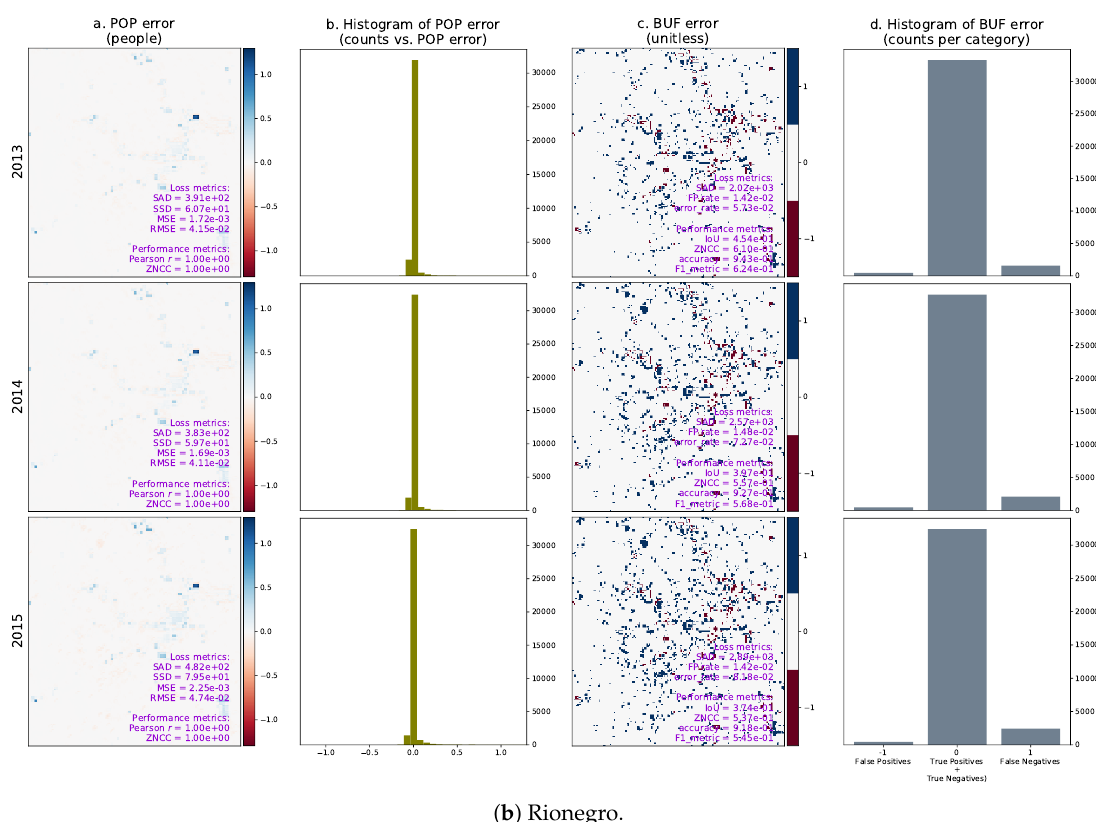
Figure 23. Framework performance in the geographic areas of interest. From left to right, the columns correspond to: (1) population distribution error (i.e., real value - predicted value); (2) histogram of the population distribution error; (3) binary urban footprint error (i.e., real value - predicted value); (4) histogram of the binary urban footprint error. POP = predicted population distributions; BUF = binary urban footprints; ZNCC = zero-mean normalized cross-correlation; SAD = sum of absolute differences; SSD = sum of squared